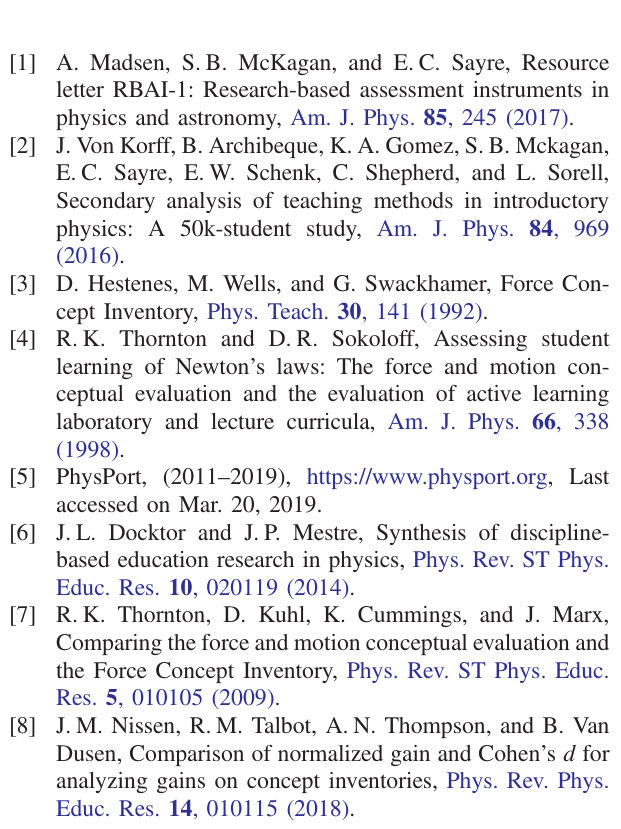
letter RBAI-1: Research-based assessment instruments in physics and astronomy, Am. J. Phys. 85 , 245 (2017).